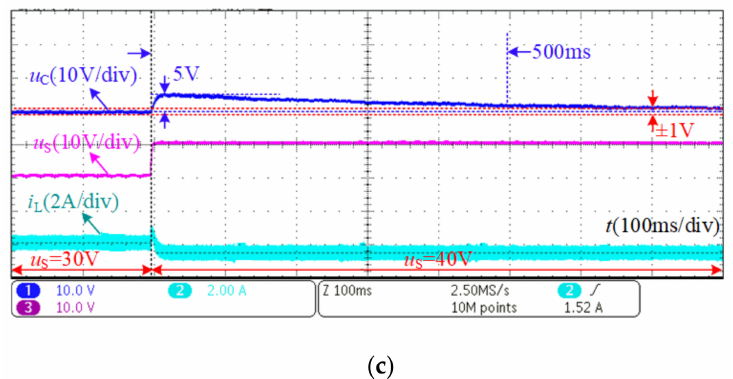
Figure 15. u C and i L experiment results of the different control strategies when u S steps from 30 V to 40 V. ( a ) The proposed control strategy; ( b ) PBC; ( c ) IDA-PBC. 2. Step Change in P CPL